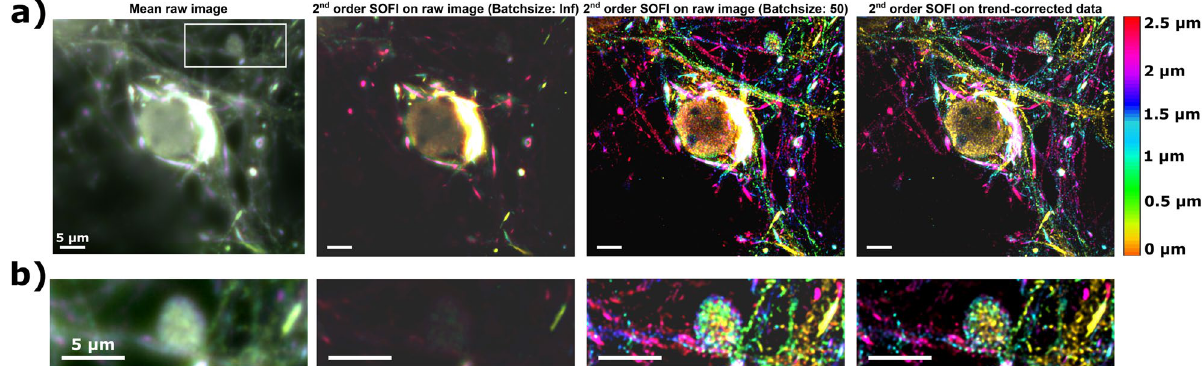
Figure 4. SOFI results on α-synuclein aggregates in a primary hippocampal neuron (treated with α-synuclein pre-formed fibrils and antibody-labeled with Alexa Fluor 647 to visualize newly formed alpha synuclein aggregates). The mean raw image is compared to the second order 3D-SOFI without and with batching (batch size of 50 frames) on the raw data and trend-corrected data. The zoom of the area indicated in the full